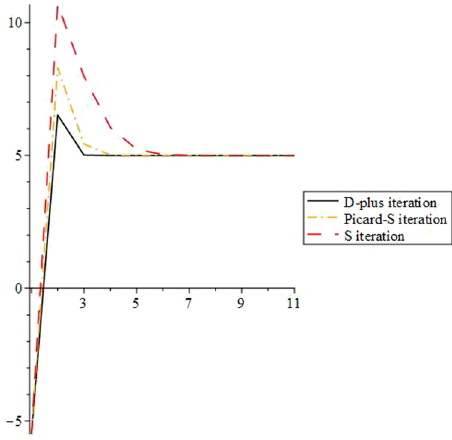
Figure 6: Convergence of D - plus, Picard - S and S - iteration processes in Example